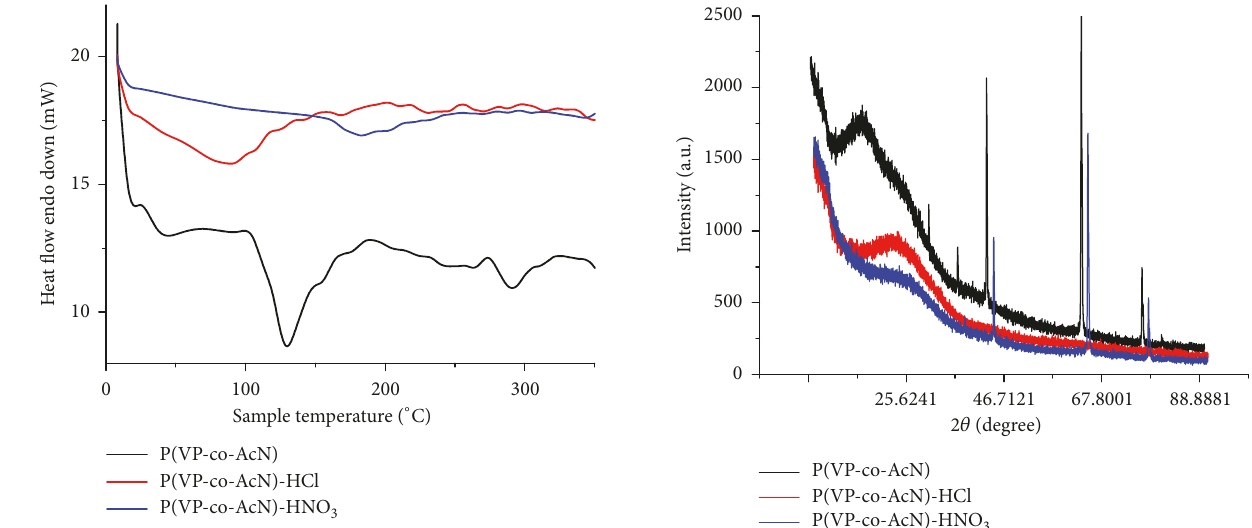
Figure 9: XRD spectra of the copolymer and the polyelectrolytes. at 129 ∘ C) compared to the corresponding